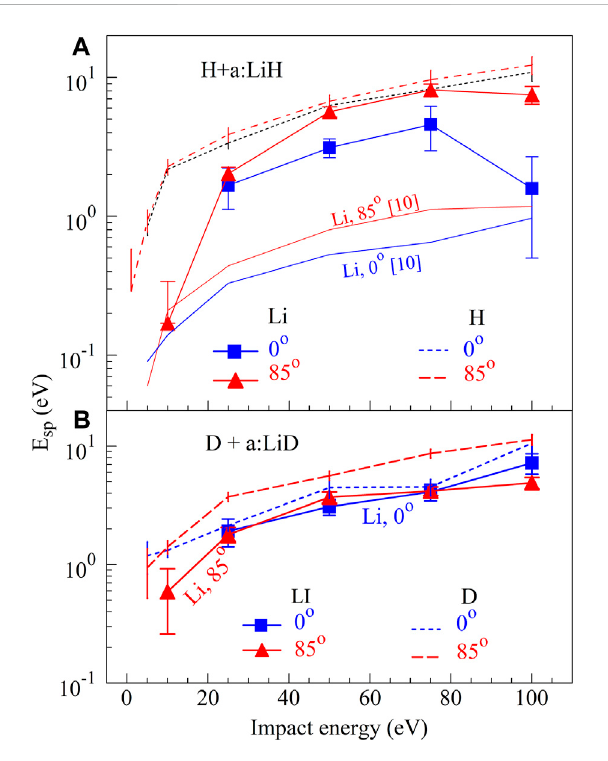
FIGURE 9 (A) Average kinetic energies ( E sp ) of the Li and H atoms, sputtered from an (A) LiH surface over a range of impact energy (E) of incident H atoms at two angles of incidence ( θ ). Averaging is done for each E and θ over all sputtering trajectories. (B) Similar plots as in (A) , but for D atoms incident at an (A) LiD